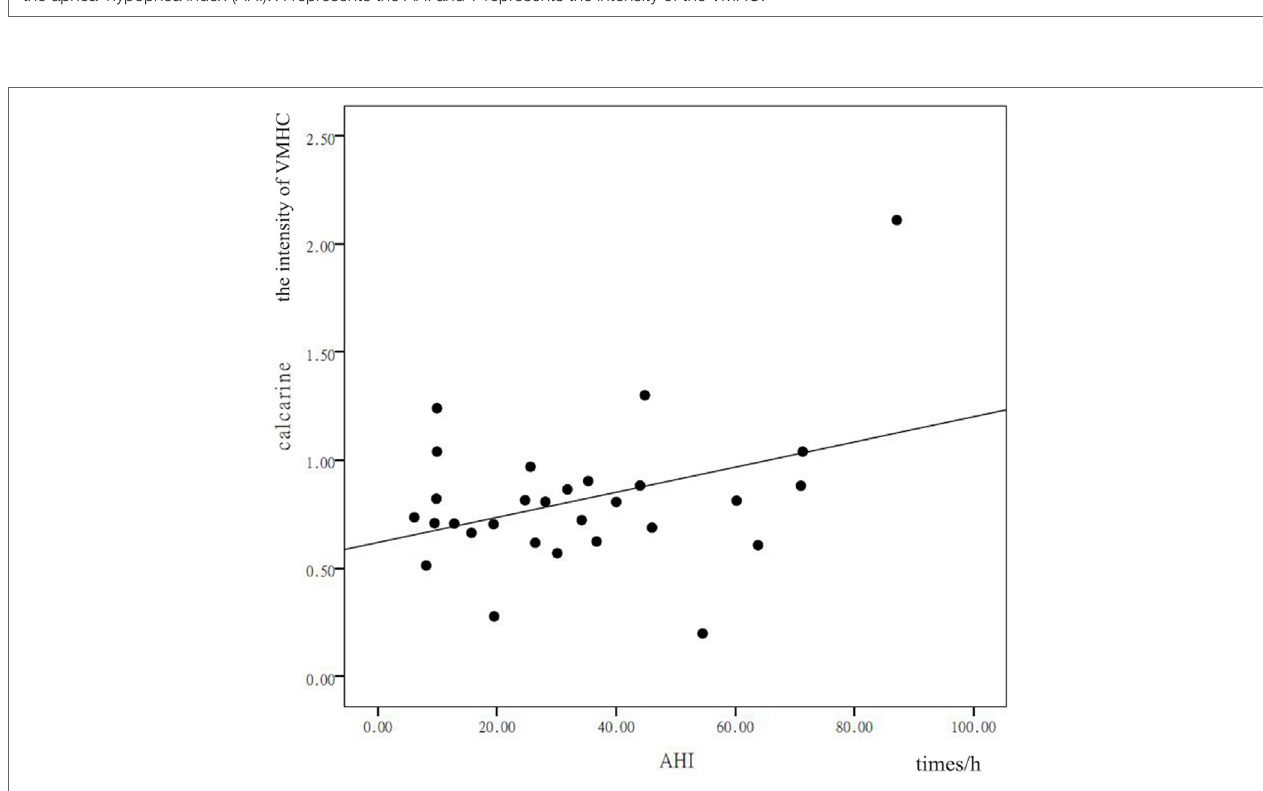
FigUre 4 | Shown is a significant positive correlation between the voxel-mirrored homotopic connectivity (VMHC) values in the precuneus and calcarine cortex, and the apnea–hypopnea index (AHI). X represents the AHI and Y represents the intensity of the